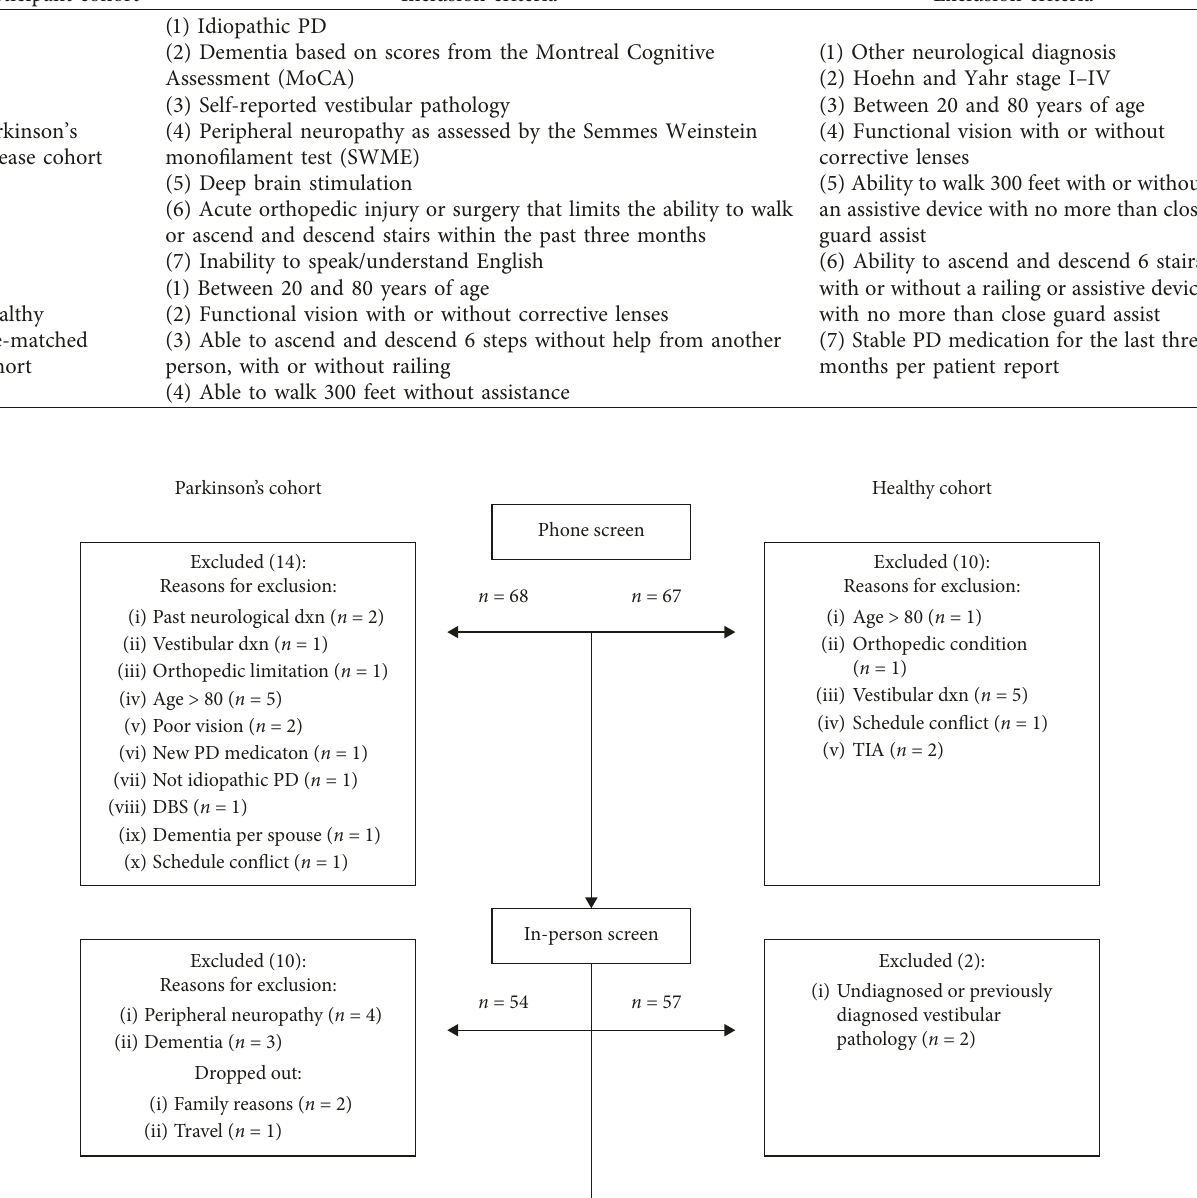
Table 1: Inclusion and exclusion criteria for Parkinson’s disease cohort and age-matched healthy cohort. Participant cohort